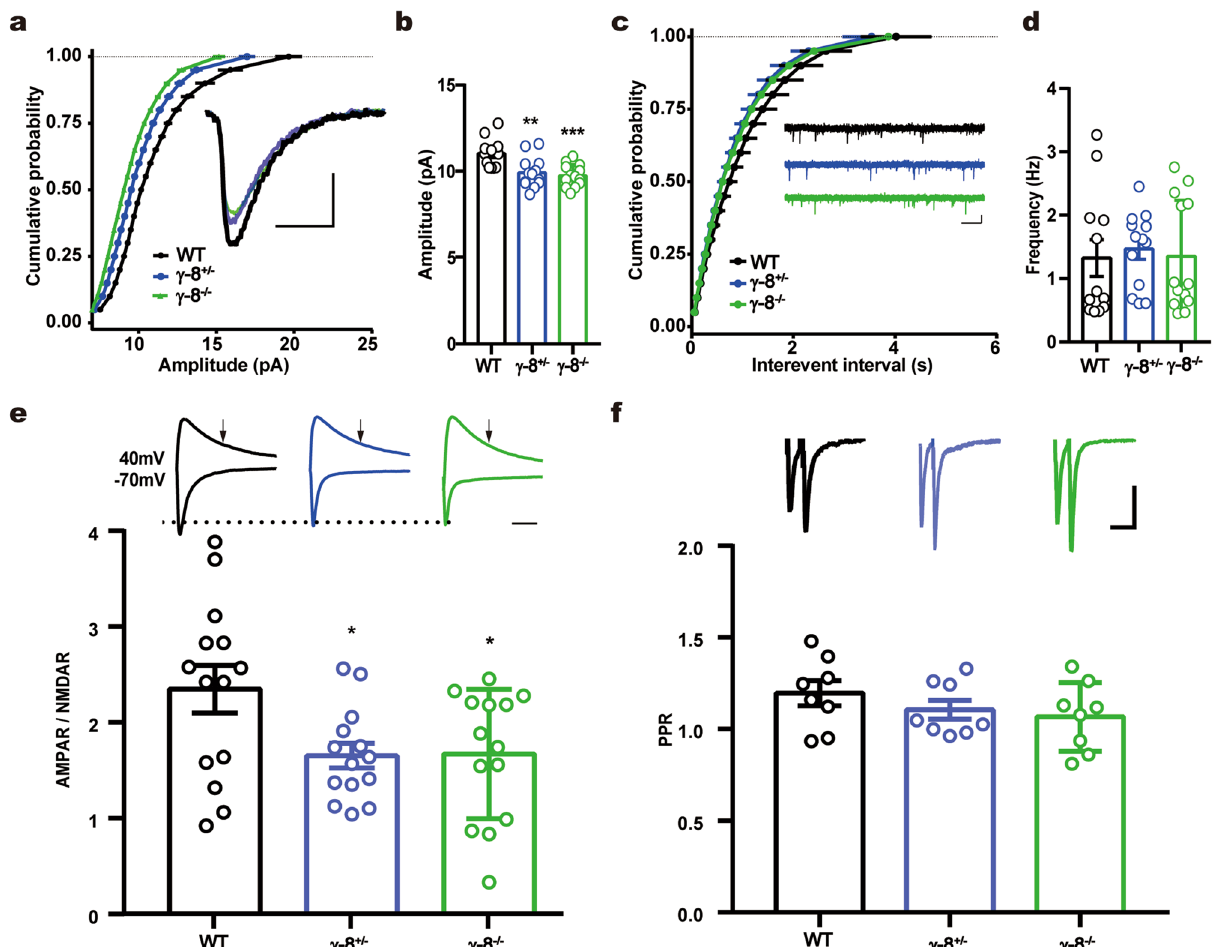
Figure 5. Synaptic AMPAR functions are impaired in mPFC TARP γ-8 knockout mice. ( a – d ) mEPSCs from γ-8 +/− and γ-8 −/− mPFC pyramidal cells had reduced amplitude but unchanged frequency. ( a ) Cumulative frequency distribution of mEPSC amplitudes. Insert shows sample traces. Scale bar, 5 pA, 5 ms. ( b ) Amplitude of mEPSC was reduced in mPFC pyramidal cells from γ-8 +/− and γ-8 −/− mice. ( c ) Cumulative frequency distribution of mEPSC interevent interval. Sample traces are shown as insert. Scale bar, 10 pA, 500 ms. ( d ) Frequency of mEPSC did not differ among WT, γ-8 +/− and γ-8 −/− neurons. (n = 12 for WT; n = 13 for γ-8 +/− ; n = 13 for γ-8 −/− ). ( e ) AMPA/NMDA ratio was reduced in mPFC pyramidal neurons from γ-8 +/− and γ-8 −/− mice (n = 14). Representative EPSCs recorded at holding of − 70 mV and + 40 mV are shown above the bar graph. Arrows indicate where NMDAR-EPSCs were measured. Scale bar, 50 ms. ( f ) Paired-pulse ratio (PPR) does not differ between WT, TARP γ-8 +/− and TARP γ-8 −/− neurons (n = 8 for each). The sample traces are shown above the bar graph. Scale bar, 50 pA, 100 ms. Data represent the mean ± s.e.m. one-way ANOVA, * p < 0.05, ** p < 0.01, *** p <